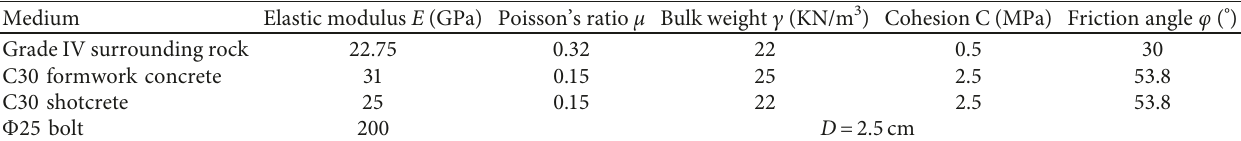
Figure 10: Finite element model: (a) original stratum; (b) meshing; (c) tunnel spray mixing, secondary lining, and pile foundation. Table 2: Physical and mechanical parameters of finite element